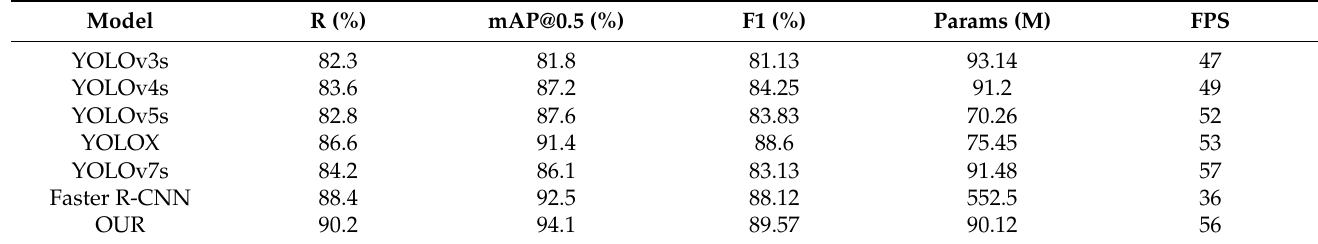
Table 7. Comparison of different detector models on the steel dataset.